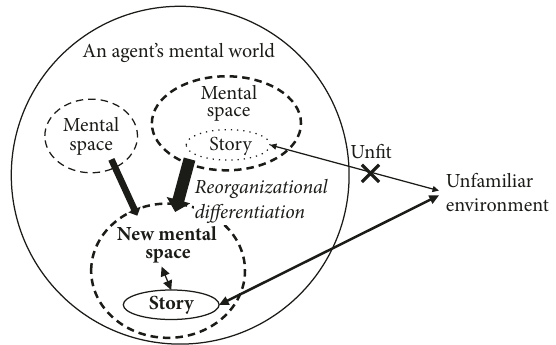
Figure 4: Reorganizational differentiation of a mental